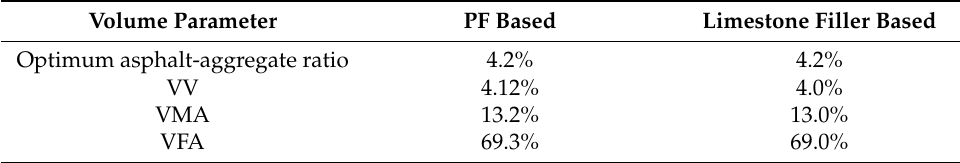
Table 9. Optimum asphalt-aggregate mass ratio and volumetric